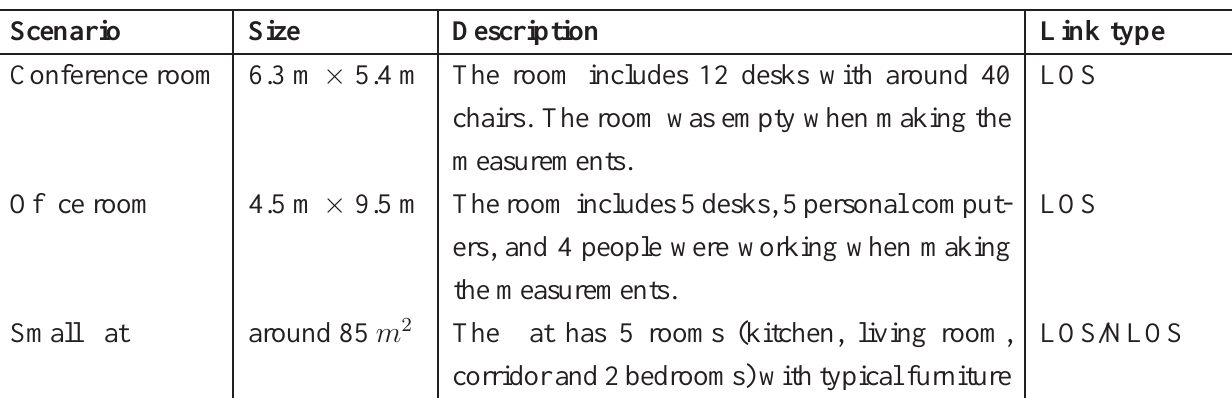
Table 1. Environment of the experiments